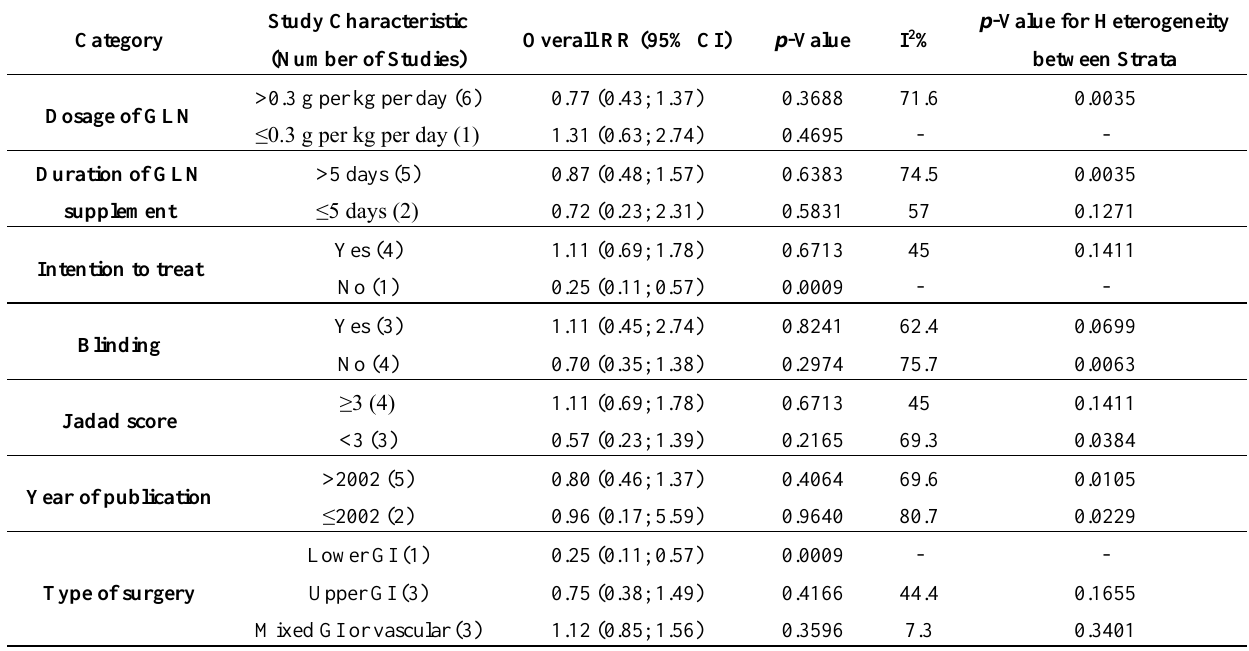
Table 2. Stratified analysis for overall morbidity comparing GLN vs.